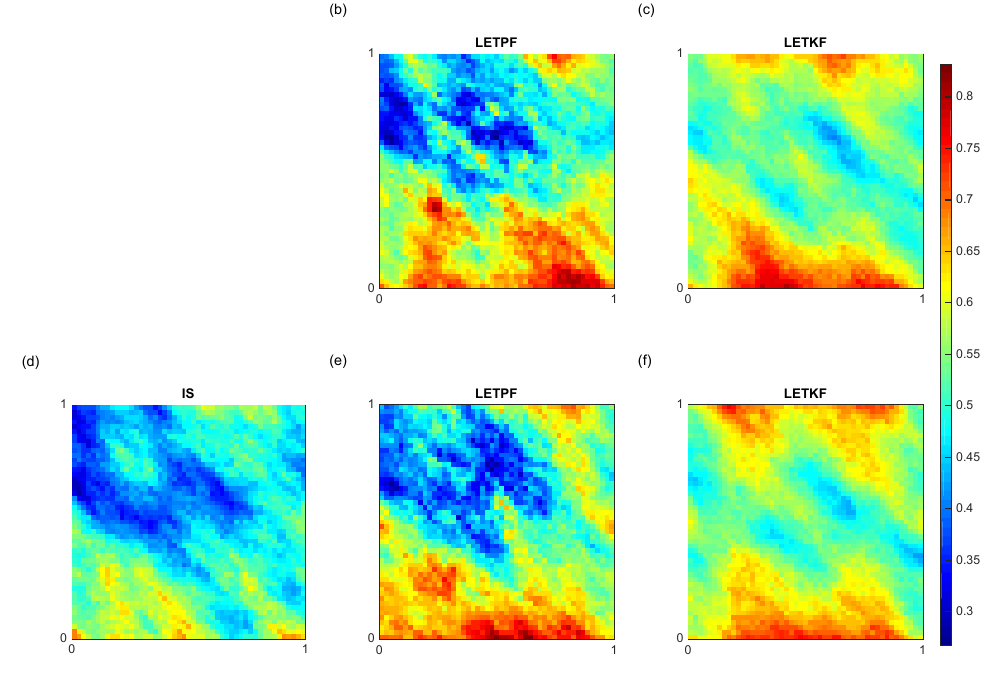
Figure 16. Same as Fig. 9 but with